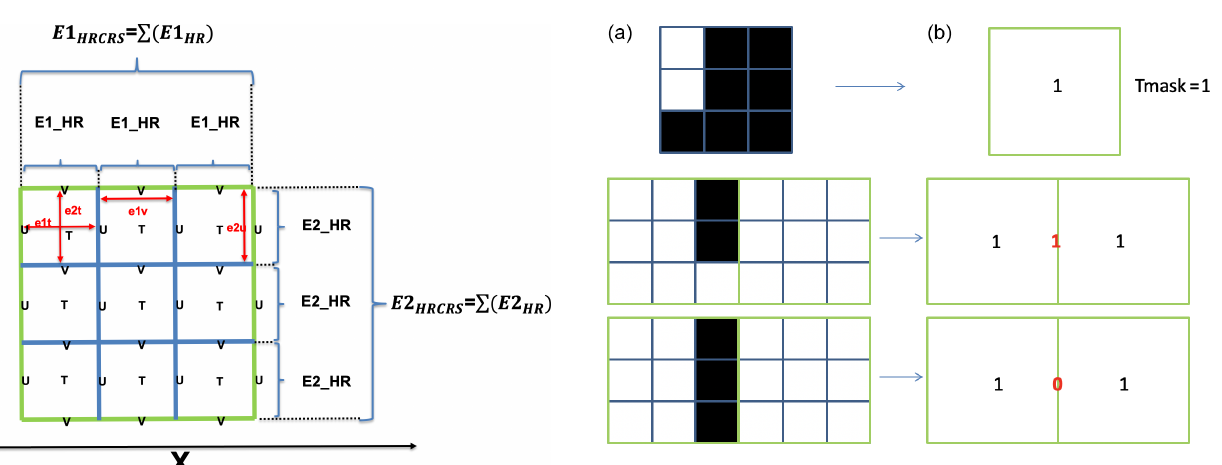
Figure 3. Schematic diagram illustrating the definition of land–sea mask from high-resolution ocean grid cells ( a , blue lines with land cells filled in black) to the corresponding coarsened biogeochemi- cal grid cells ( b , green lines, with numbers identifying whether the corresponding point, here T or U , is defined as land (0) or ocean